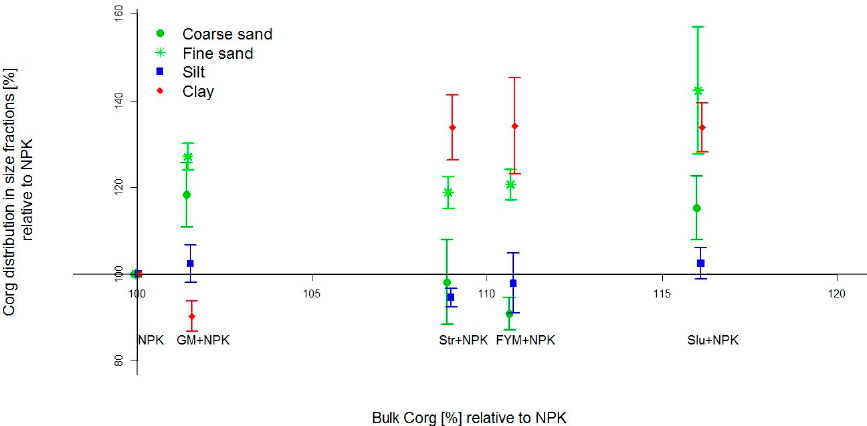
Figure 3. Distribution of relative abundance (% ± standard error, n = 3) of Corg in the different size fractions for the four organic amendments in comparison to the NPK treatment (mineral fertilization alone). Along the x -axis, each amendment treatment is ordered in relation to increasing bulk Corg content relatively to the NPK treatment (see Table 2). For each size fraction, mean value of each treatment was ranked by increasing mean content of Corg g · kg − 1 of bulk soil. NPK : mineral fertilization alone where N, P, and K refer to mineral nitrogen, phosphorus and potassium; GM + NPK : green manure + mineral fertilization; Str + NPK : cereal straw + mineral fertilization; FYM + NPK : farmyard manure + mineral fertilization; Slu + NPK : cattle slurry + mineral fertilization.